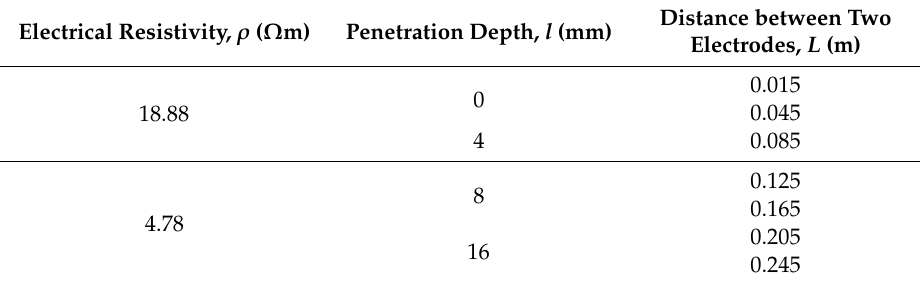
Table 1. List of experimental test cases.